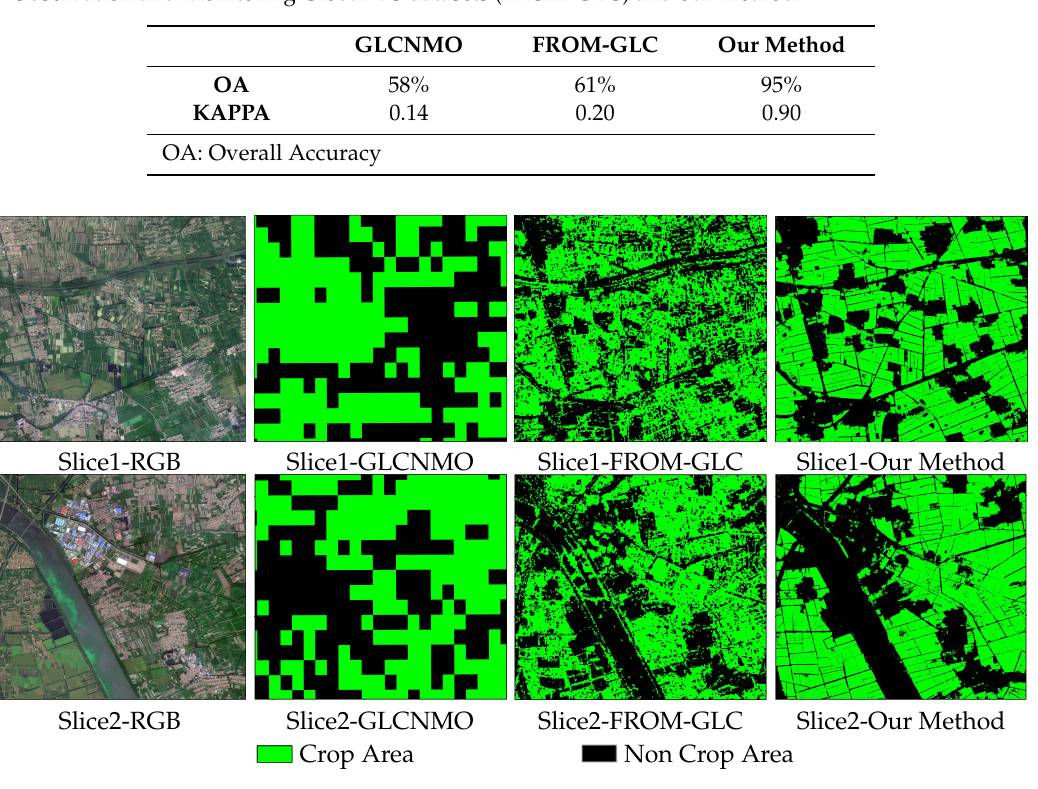
Figure 8. The two WorldView-2 image slices with red-greed-blue (RGB) bands, and the results from the Global Map–Global LC (GLCNMO) and Finer Resolution Observation and Monitoring Global LC datasets (FROM-GLC) and our method.